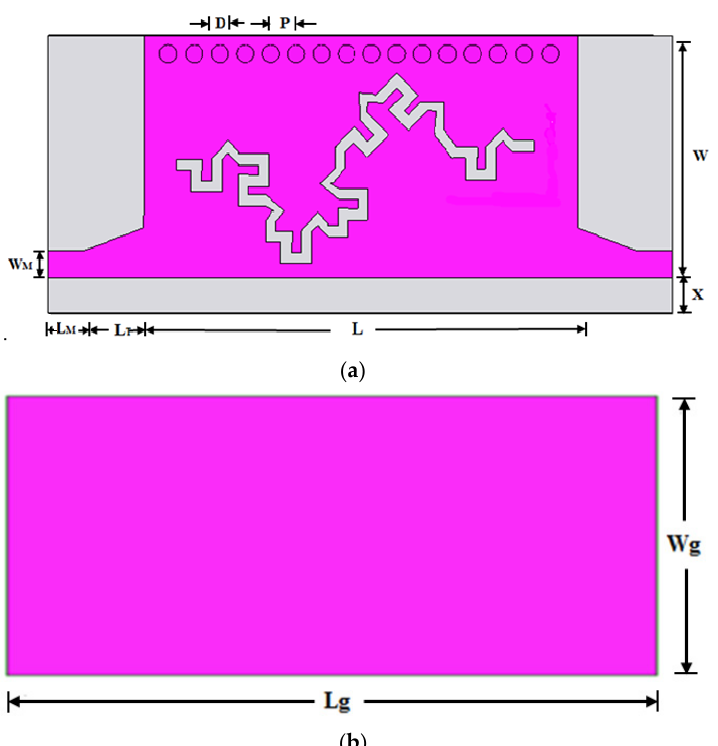
Figure 4. ( a ) Top view of HMSIW integrated with hybrid fractal. ( b ) Back view of HMSIW integrated with hybrid fractal.